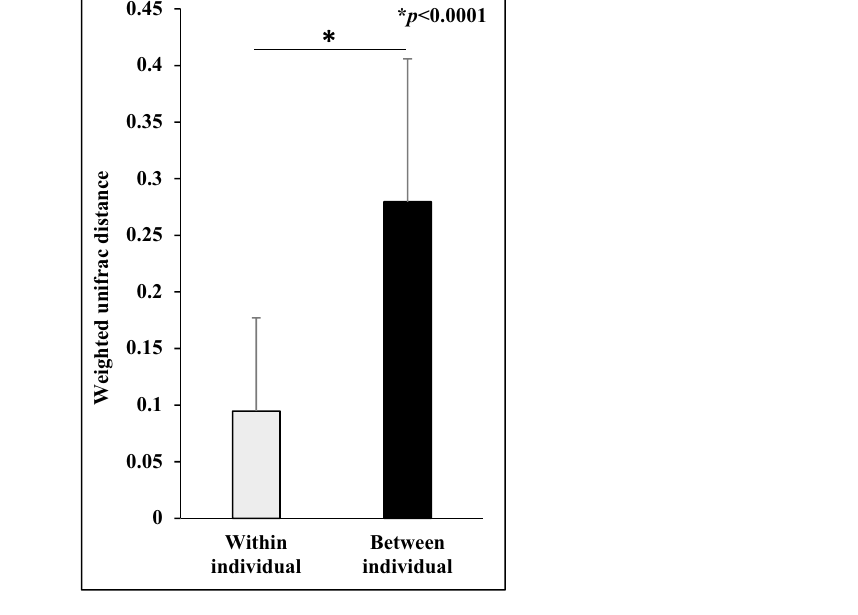
Figure 1. Comparison of weighted Unifrac distances within and between individual